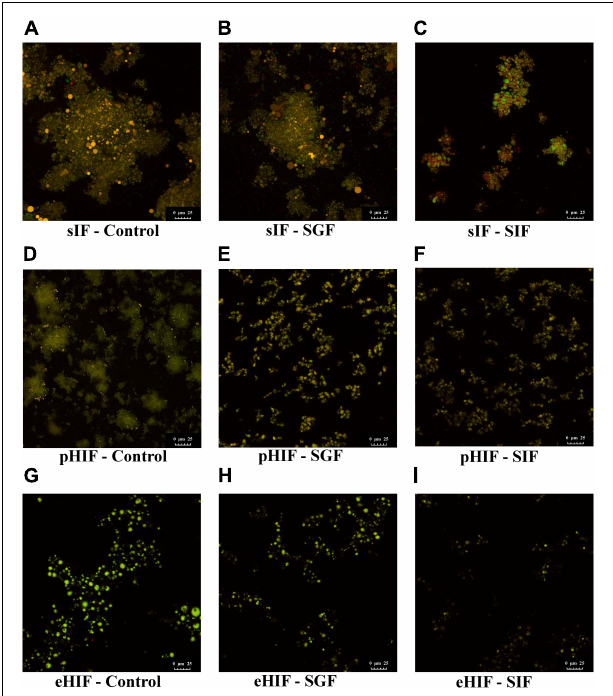
FIGURE 4 | Microstructures of proteins and lipids in infant formulas during in vitro digestion. (A–C) Represent the sIF during control, SGF, and SIF digestion stages, respectively. (D–F) Represent the pHIF during control, SGF, and SIF digestion stages, respectively. (G–I) Represent the eHIF during control, SGF, and SIF digestion stages,